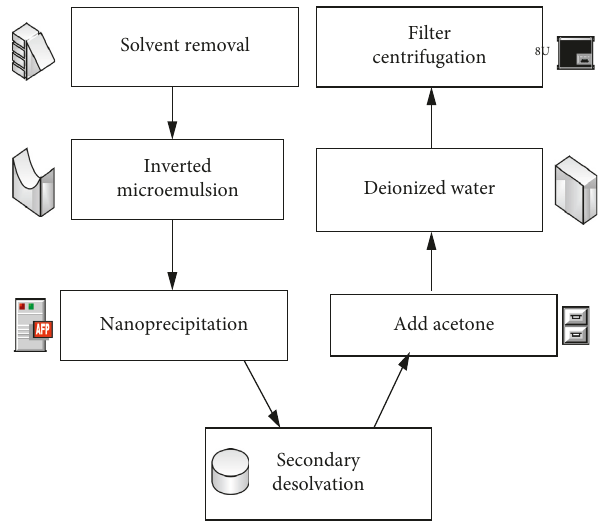
Figure 3: Nanoparticle laser engraving